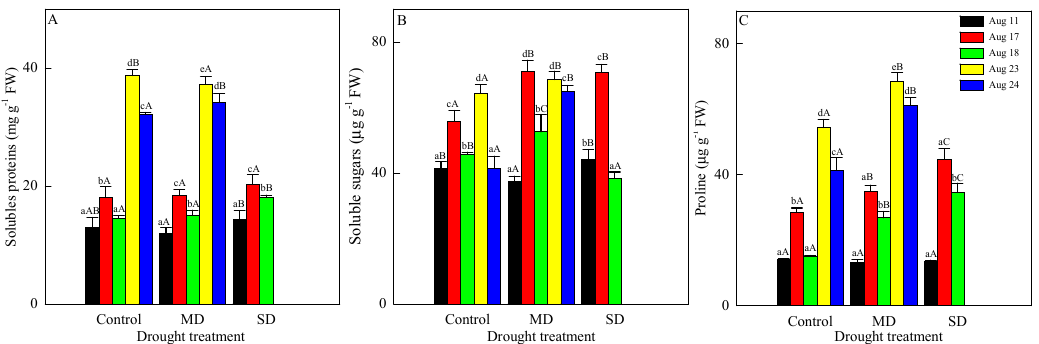
Figure 4. Changes in the ( A ) soluble proteins, ( B ) soluble sugars, and ( C ) free proline of A. halodendron under drought and in the rehydration phase. Values represent mean ± SE. Bars labelled with different lowercase letters represent significant differences among days for a given treatment. Bars labelled with different capital letters differ significantly among drought treatments on a given day. 11, 17 and 23 August 2018 correspond to drought, 18 and 24 August 2018 correspond to rehydration.